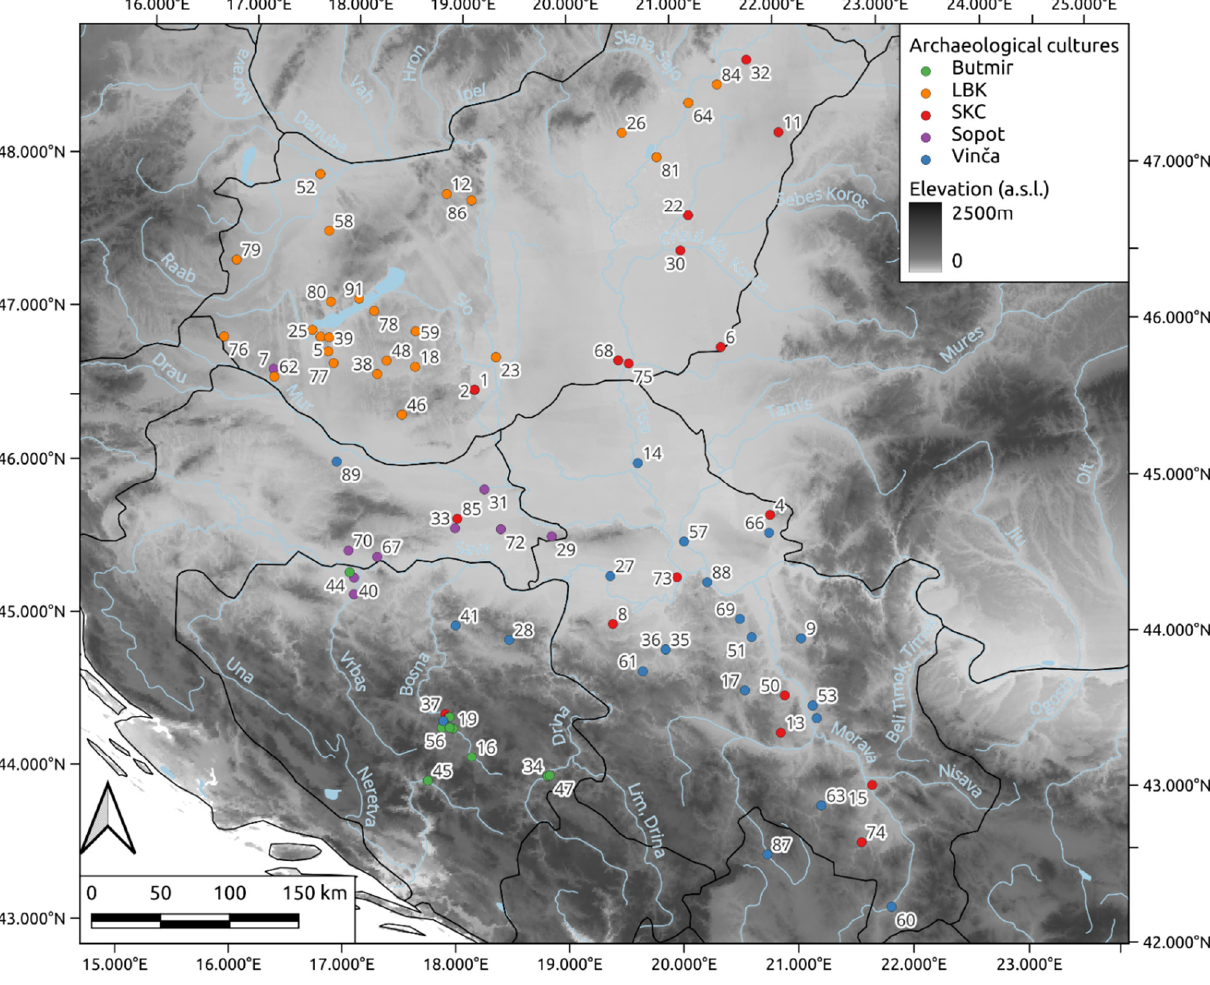
Figure 1. Distribution of sites with archaeobotanical assemblages analysed in this study. See